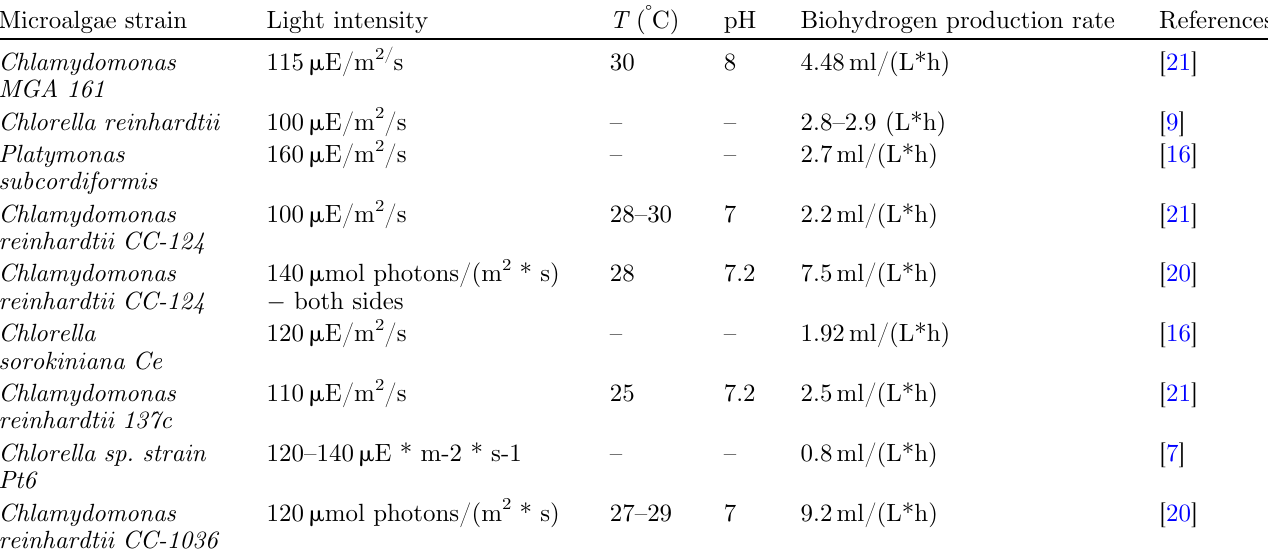
Table 12. Typical microalgal biohydrogen